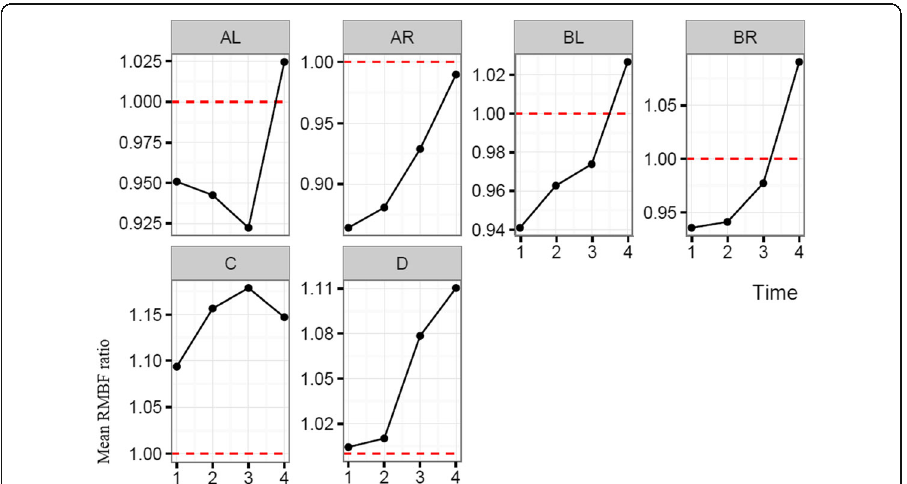
Fig. 4 Mean regional microcirculation blood flow (RMBF) ratio from baseline ( y axis), for all subjects at each anatomical region of interest, over time ( x